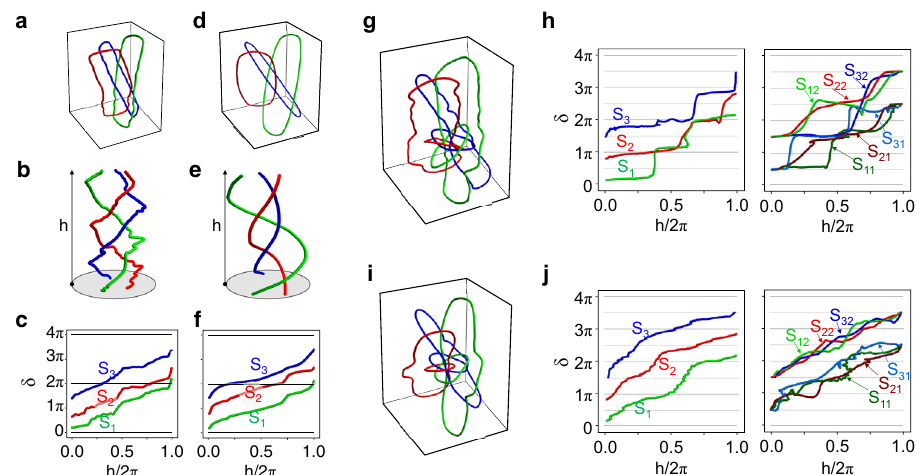
Fig. 4 Optical nested vortex knotted and linked structures. a Experimental results of the nested linked structure with one generation. b Braid versions of the nested link shown in a . c Twisting angles of three strands (S 1 , S 2 , and S 3 ) in the braid shown in b . d – f Theoretical results corresponding to the a – c based on the angular spectrum theory of the light fi eld. g Experimental results of the nested linked structure with two generations. h Twisting angles of three strands in the fi rst generation (S 1 , S 2 , and S 3 ) and six strands in the second generation (S 11 , S 12 , S 21 , S 22 , S 31 , and S 32 ) contained in nested linked structure (shown in g ). i , j are the theoretical results corresponding to the g , h based on the angular spectrum theory of light fi eld,